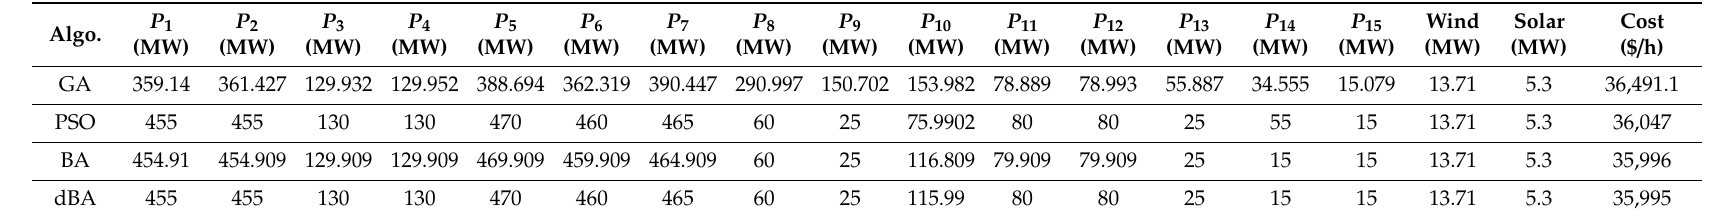
Table 14. Cost comparison for 3000 MW demand with